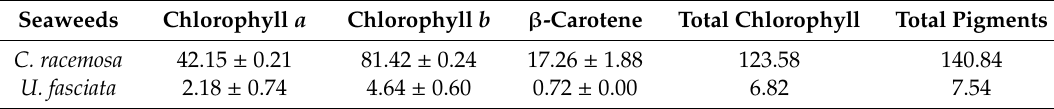
Table 7. Pigment contents (mg / g dw) of Caulerpa racemosa and Ulva fasciata . Seaweeds